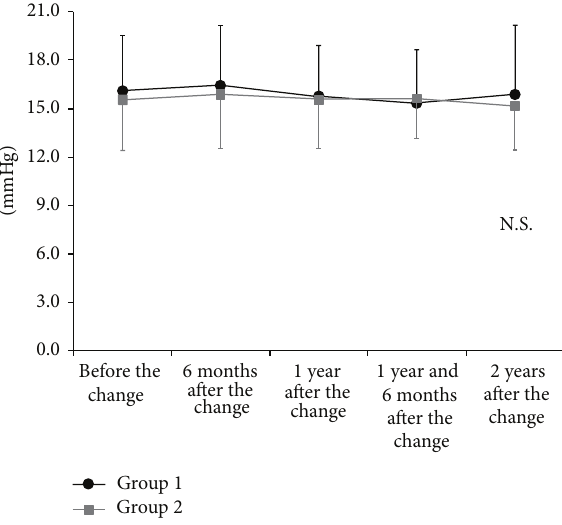
Figure 1: Intraocular pressure (IOP) before and after changing to latanoprost/timolol maleate fixed-combination eye drops or to dor- zolamide/timolol maleate fixed-combination eye drops (ANOVA or Bonferroni/Dunnett analysis). The IOP was not significantly differ- ent from baseline at any time point examined in either medication group. Average data are presented and error bars represent one standard deviation.